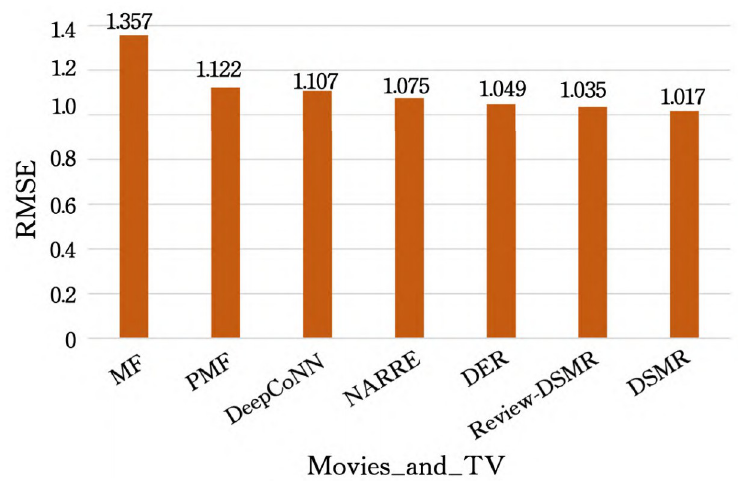
Fig 4. Performance comparison with data equal